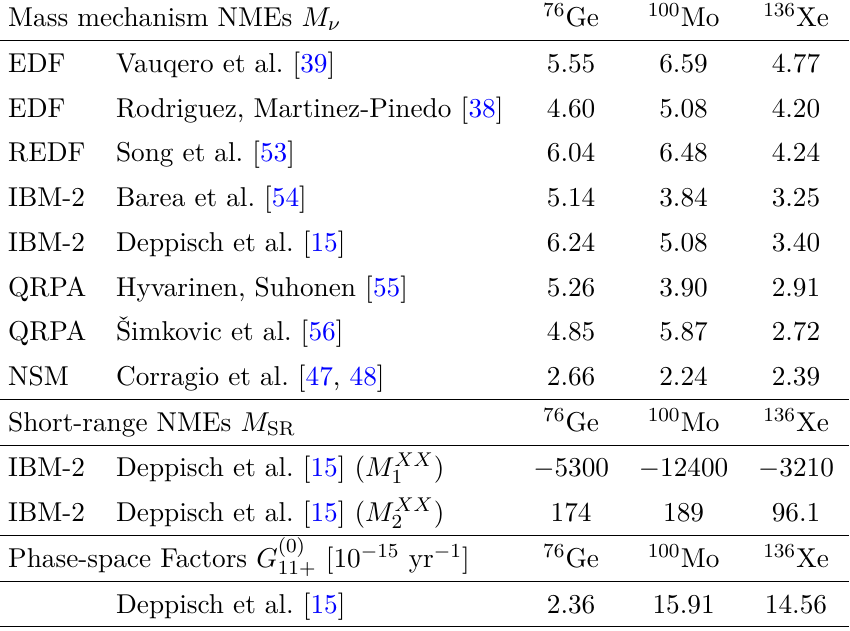
Table 1 . Light-neutrino exchange and short-range NMEs for 0 νββ decay, calculated in different nuclear structure frameworks and adapted from [57], and phase-space factors for the three isotopes under